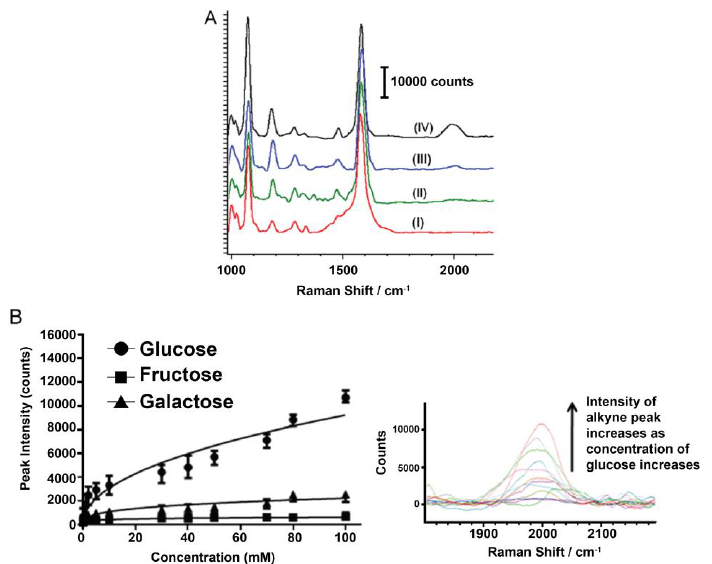
Figure 3. ( A ) Comparison of SERS spectra of phenylboronic acid-functionalized substrate with (I) no analyte, and 10 mM of (II) fructose, (III) galactose, and (IV) glucose; ( B ) SERS intensity of alkyne peak at 1996 cm −1 with various concentrations of glucose, galactose, and fructose. Inset is the Raman spectra, showing the alkyne peak with various concentrations of glucose. Reprinted from Ref. [70], Copyright (2014), with permission from